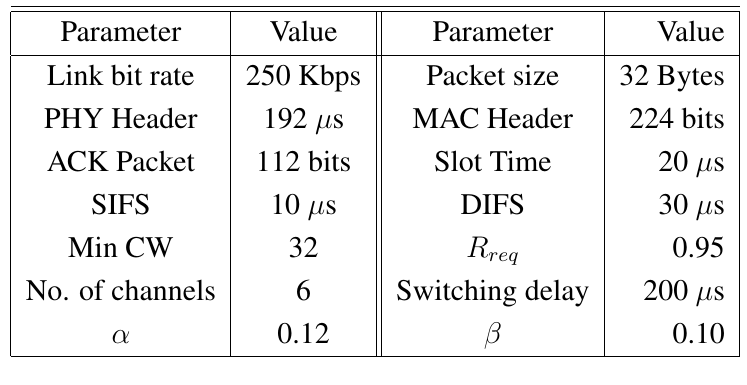
Table 1. System parameters used in